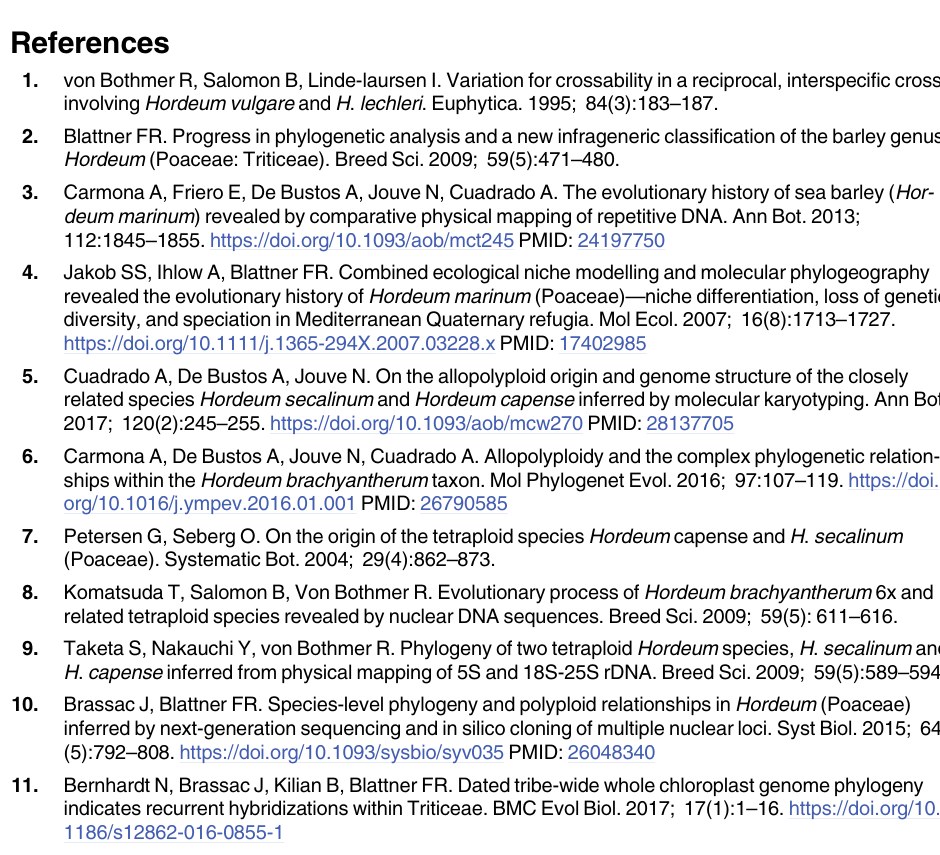
S2 Table. Maximum likelihood fits of nucleotide substitution